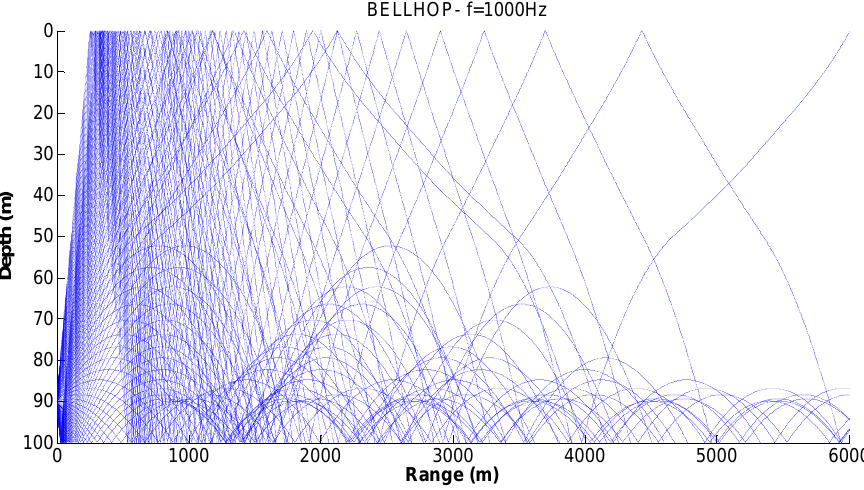
Figure 7. Corresponding ray trace for a source depth of 90 m.